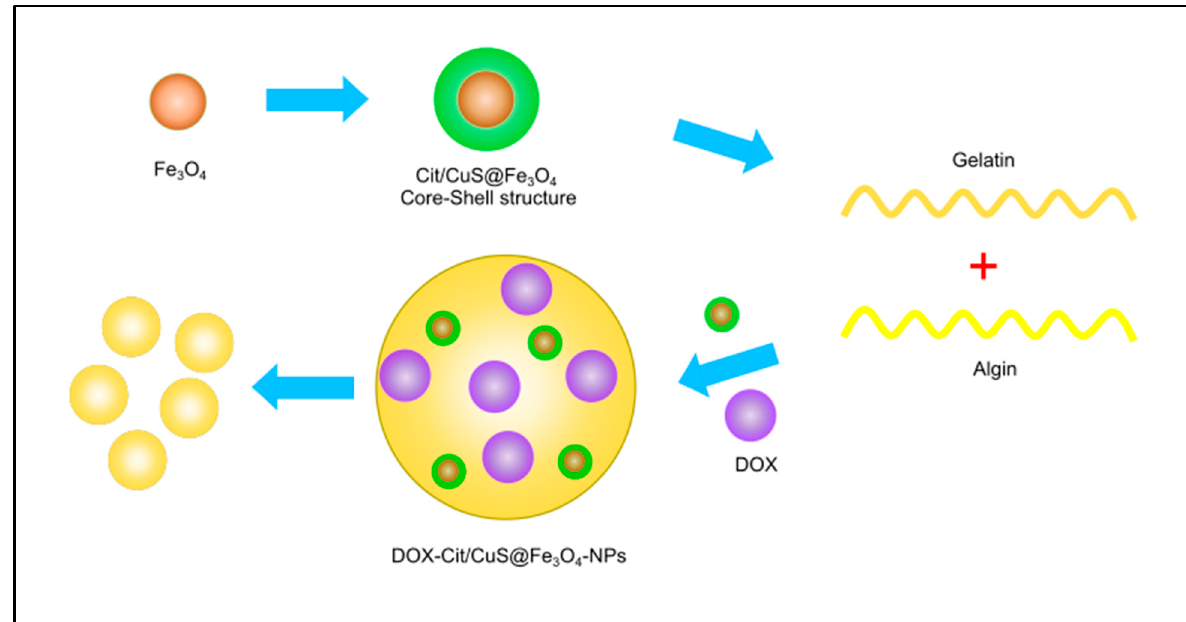
Figure 6. Schematic illustration of DOX-citric acid/CuS@Fe 3 O 4 . An example of transition metals utilized as nanocarriers. Doxorubicin: DOX (figure created with Inkscape).